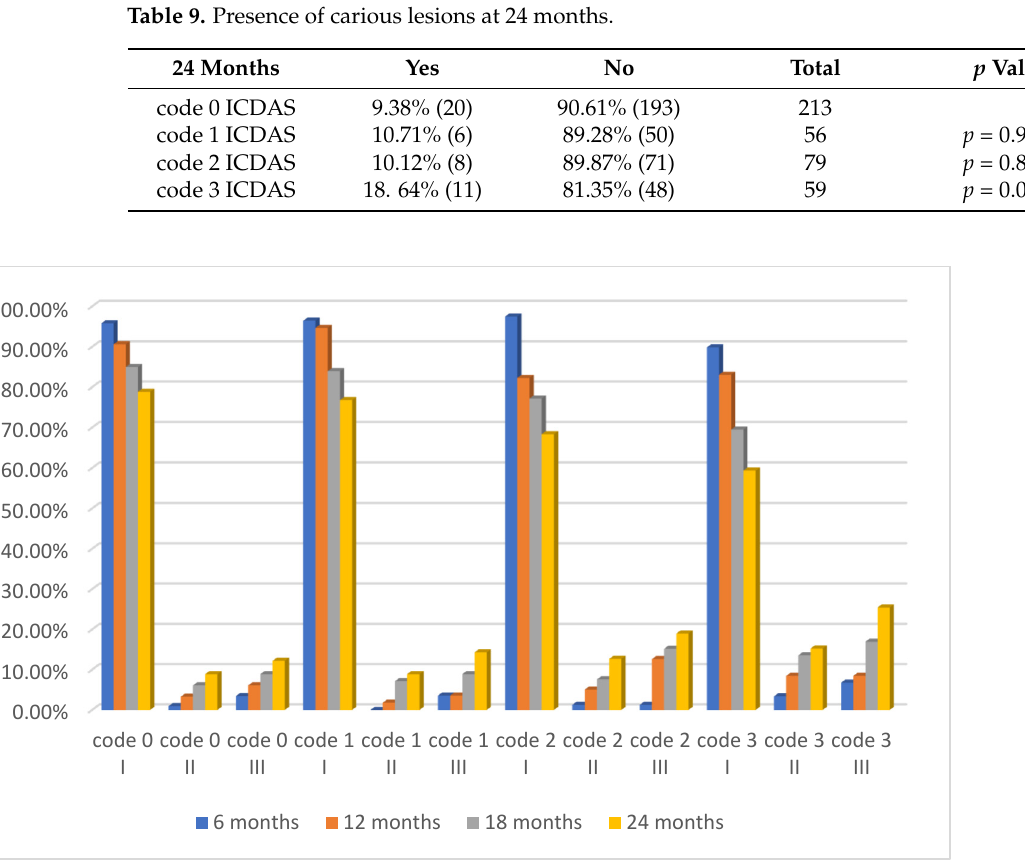
- Table 7. Presence of carious lesions at 12 months. 6 Months